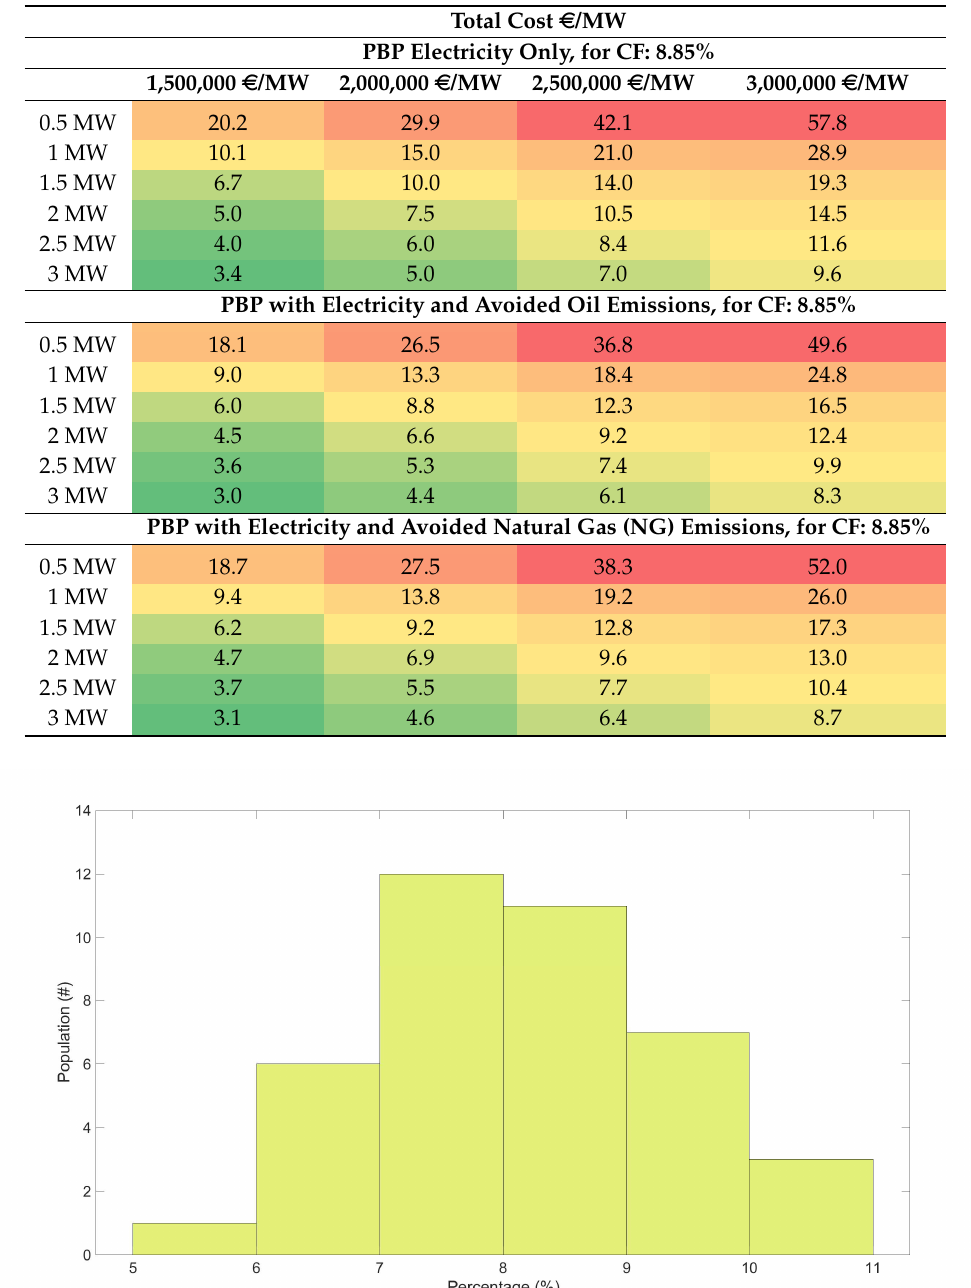
Table 3. PBP for different scenarios, quantifying the avoided emissions as added revenue stream for an Genoa optimised OWC.